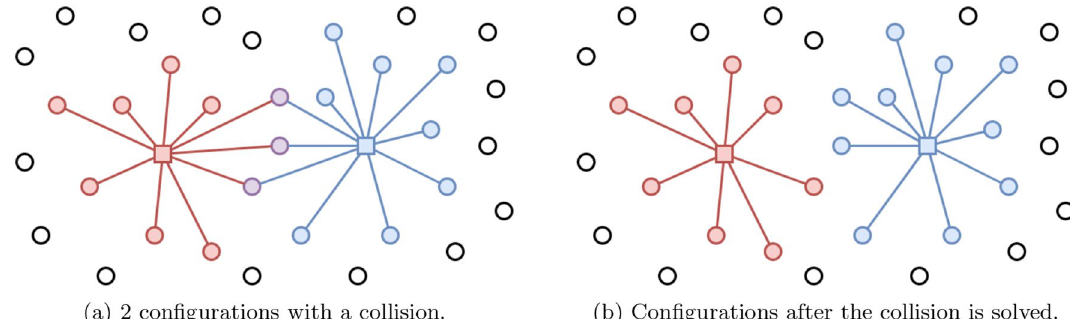
Fig. 1 An invalid and a valid combination of two